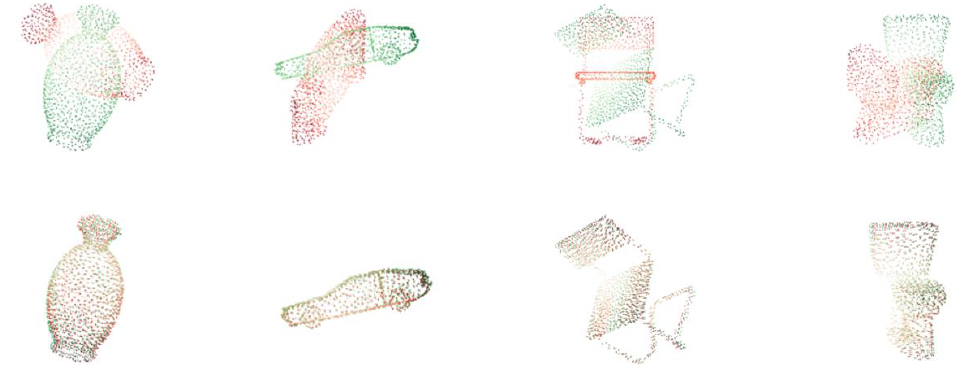
Figure 2. Registration results (red: source point cloud, green: template point cloud). The initial positions of the two point clouds are shown at the top and the results of the alignment are shown at the bottom. It can be seen that the proposed network can also achieve good registration results for methods that may fall into the local optimal solution due to the highly symmetric point cloud.